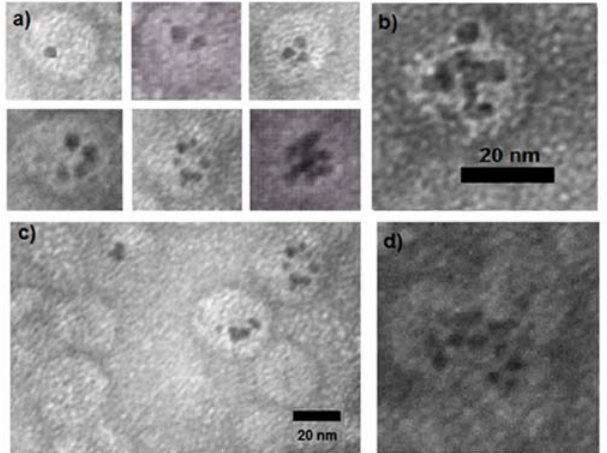
Figure 5. Negative stained TEM micrographs of 5 nm AuNPs encapsidated by the CCMV CP at pH = 4 and I = 0.1 M. The black dots are the AuNPs. ( a ) and ( b ) Single capsids containing from 1 to 10 AuNPs. ( c ) General image showing empty capsids and single capsids containing several AuNps. ( d ) A high number of nanoparticles trapped in a jointed capsid structure.